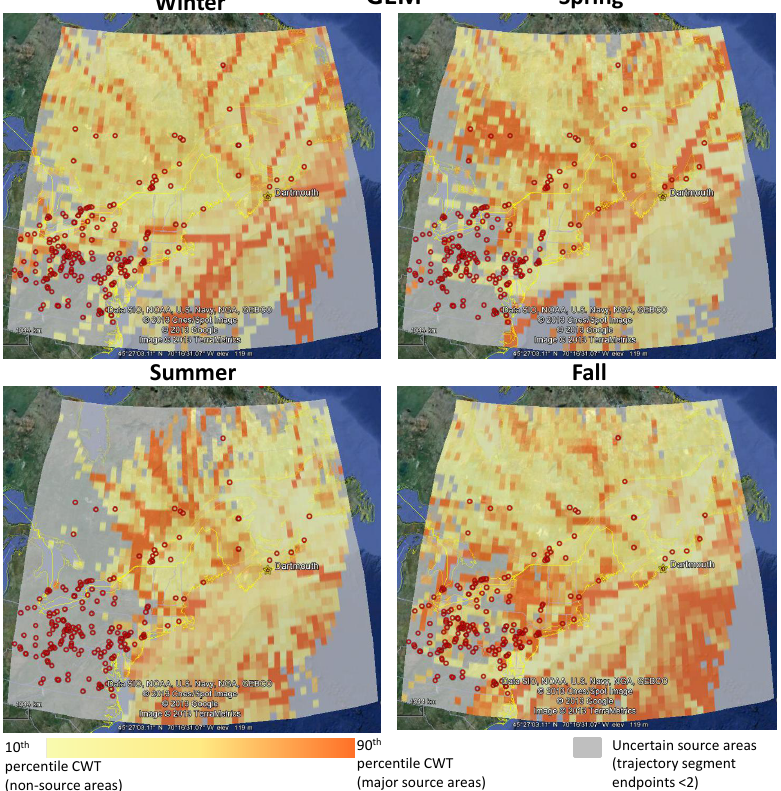
Fig. 4. CWT plots for GEM for each season. Major source areas are dark orange-shaded ( ≥ 90th percentile of seasonal CWTs); non-sources areas are light yellow-shaded ( ≤ 10th percentile of seasonal CWTs); uncertain source areas are grey-shaded. Red circles are the locations of known industrial Hg sources emitting > 5kg of Hgyr − 1 in 2010 and